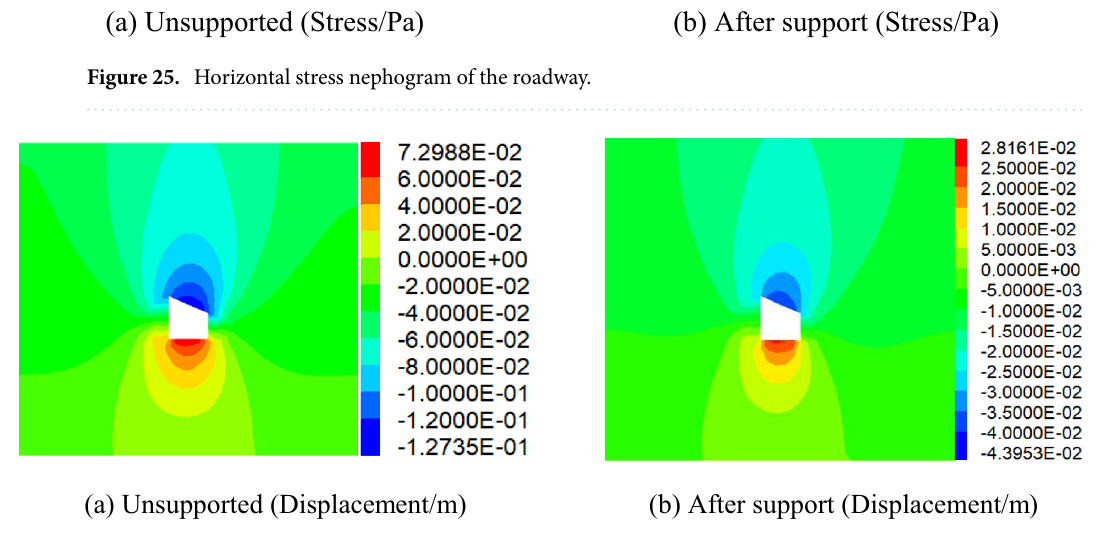
Figure 26. Vertical Displacement nephogram of the